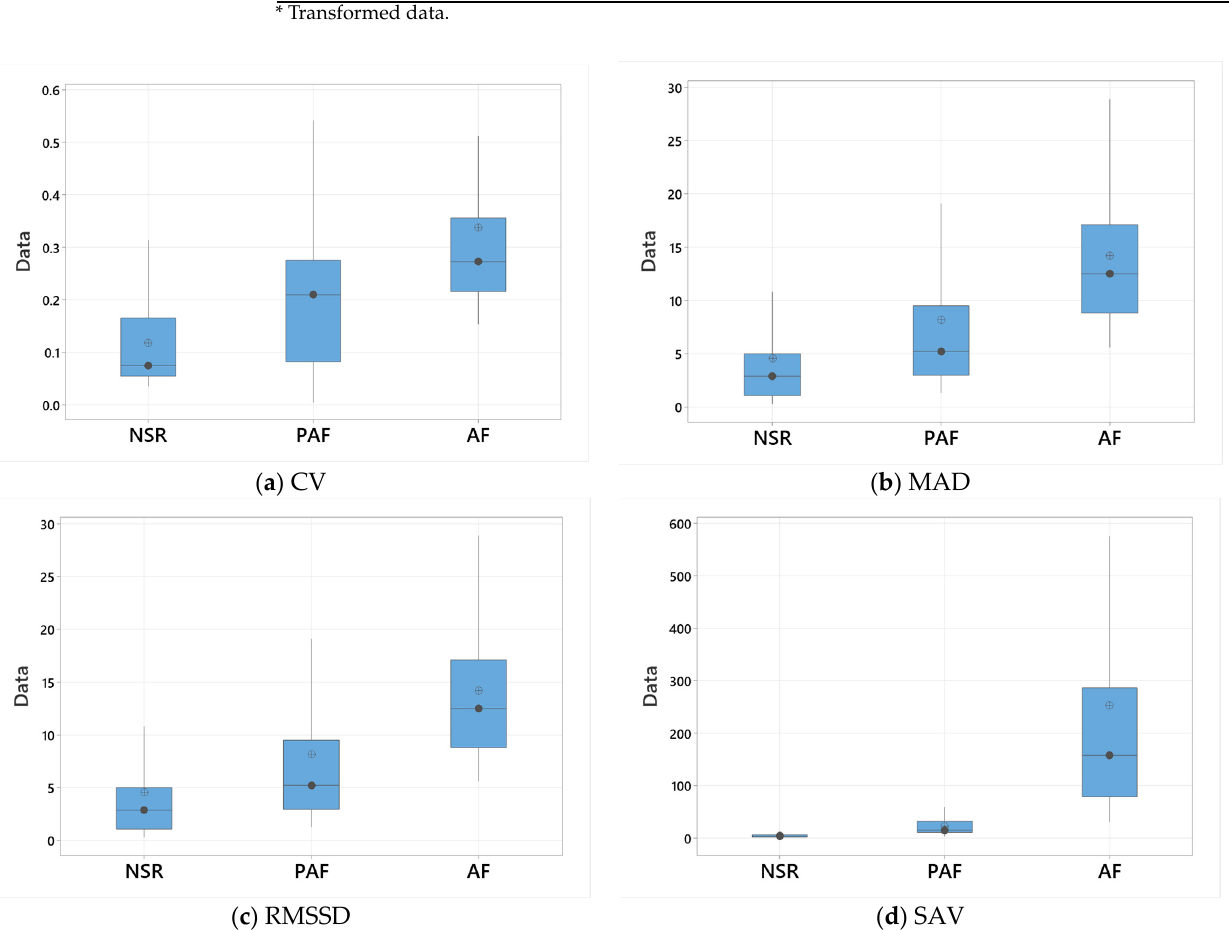
Figure 5. Box plots of